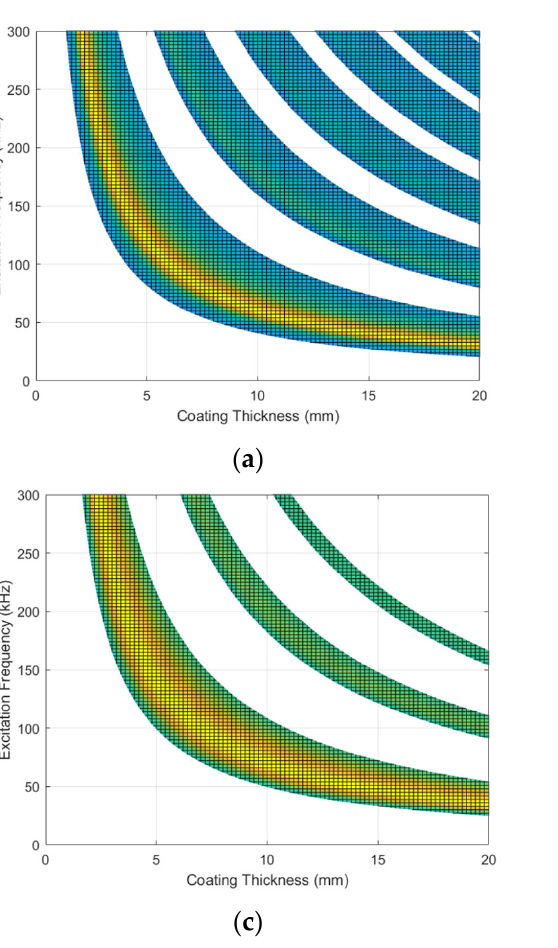
Figure 8. Intervals of interfacial shear delamination in the excitation frequency domain and the coating thickness domain as [ (cid:101) σ − 1 ] = 1.8, the coating is frost and the substrate is molybdenum ( a ), steel ( b ), and titanium ( c